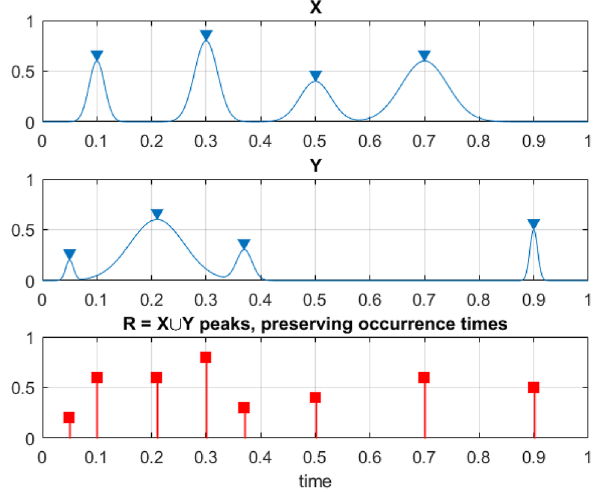
Figure 1. Illustration of how two exemplary processes, X and Y, are combined into a new synthetic vector R ( t )